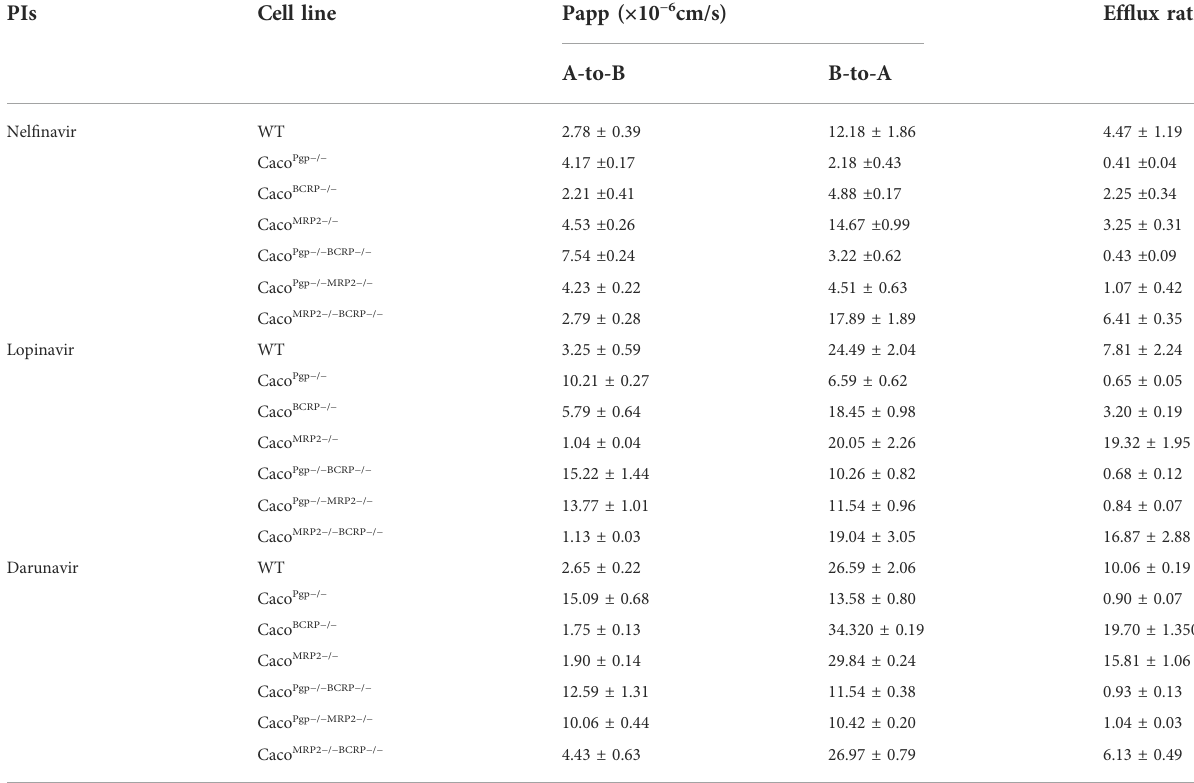
TABLE 2 Permeability and ef fl ux ratios of nel fi navir (5 μ M), lopinavir (5 μ M) and darunavir (5 μ M) across cell monolayers.